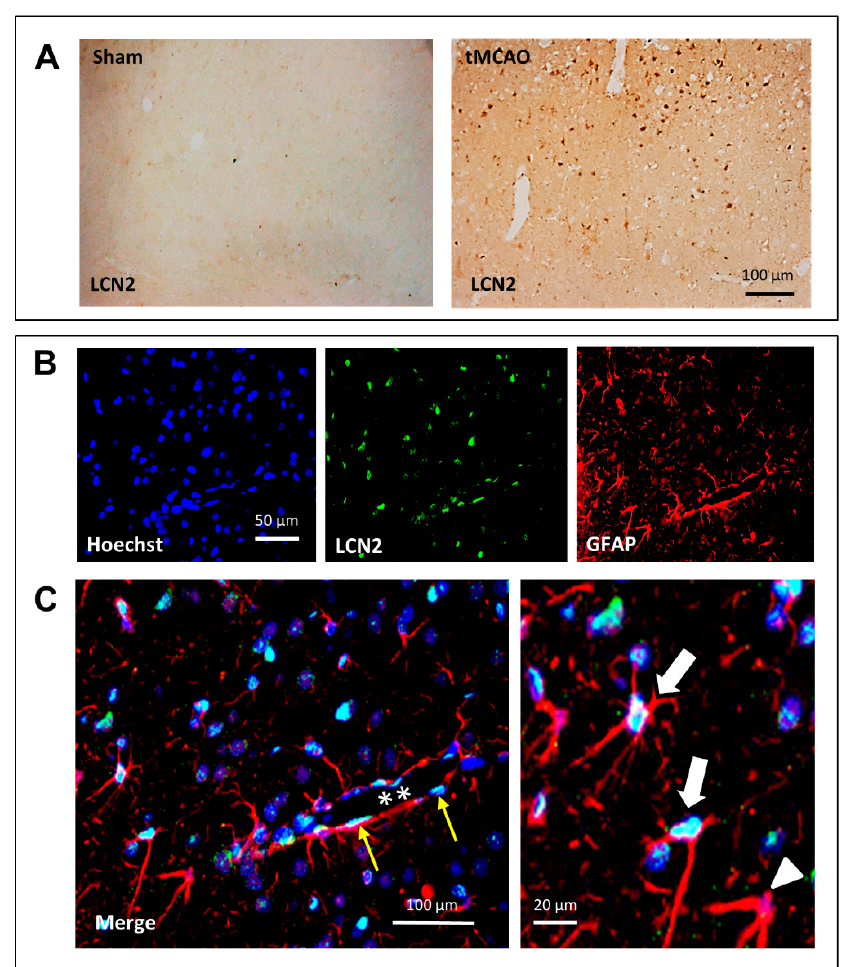
Figure 2. Immunohistochemical ( A ) and double-immunofluorescence ( B ) staining of LCN2 after stroke in the cerebral cortex of tMCAO rats. (A) Numbers of LCN2-positive cells massively increased after tMCAO. In sham-operated animals, almost no LCN2-positive cells were visible. ( C ) Double-labeling revealed that many GFAP-positive (red) astrocytes are also positive for LCN2 (turquoise-white). In ( C ), a blood vessel (stars) crosses the section, and thin elongated endothelial cells (yellow arrows) can be identified. At higher magnification, two LCN2-positive (white arrows) and a LCN2-negative (white arrowhead) can be seen.